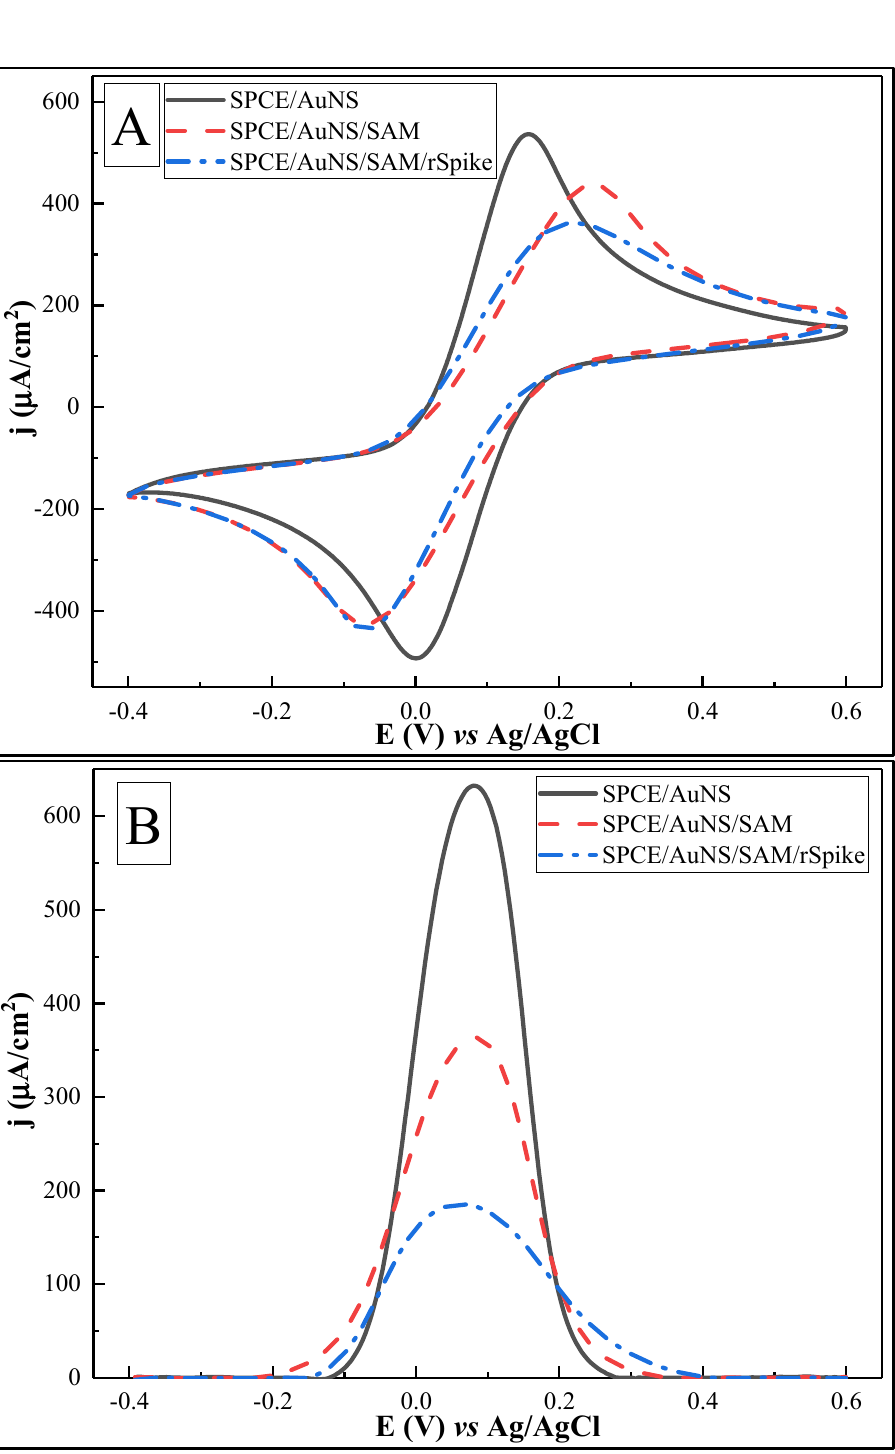
Figure 7. Cyclic voltammograms ( A ) and differential pulse voltammograms ( B ) of SPCE/AuNS (—), after SPCE/AuNS/SAM formation (- - -), and for SPCE/AuNS/SAM/rSpike protein immobilization (- · -). Potential range was from − 0.4 to +0.6 V, with a CV scan rate of 0.05 V/s, DPV step size of 0.004 V, pulse height of 0.05 V, pulse period of 100 ms, and pulse width of 50 ms, in 10 mM PBS, pH 7.4, containing 2 mM [Fe(CN 6 )] 3 − /4 − . Signal normalized to the geometrical area of the working electrode (0.126 cm 2 ).